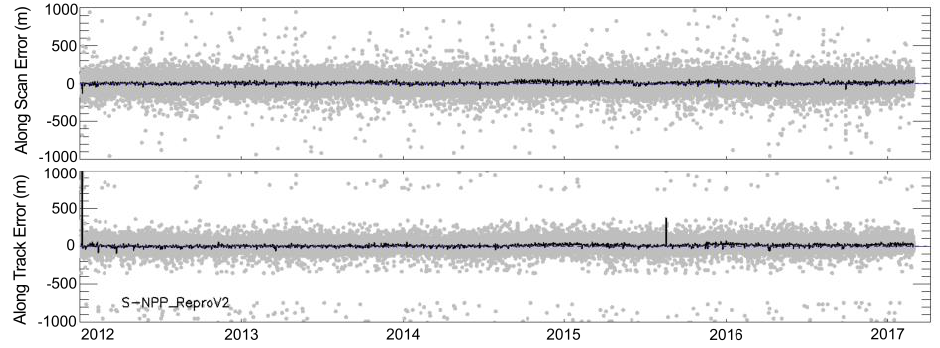
Figure 17. S-NPP VIIRS I-bands’ geolocation errors in the along-scan ( top ) and along-track ( bottom ) directions for the version 2 reprocessed geolocation products.